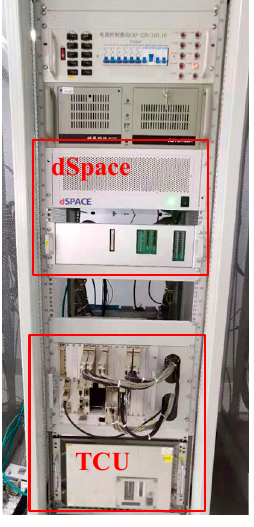
Figure 3. HILS platform.